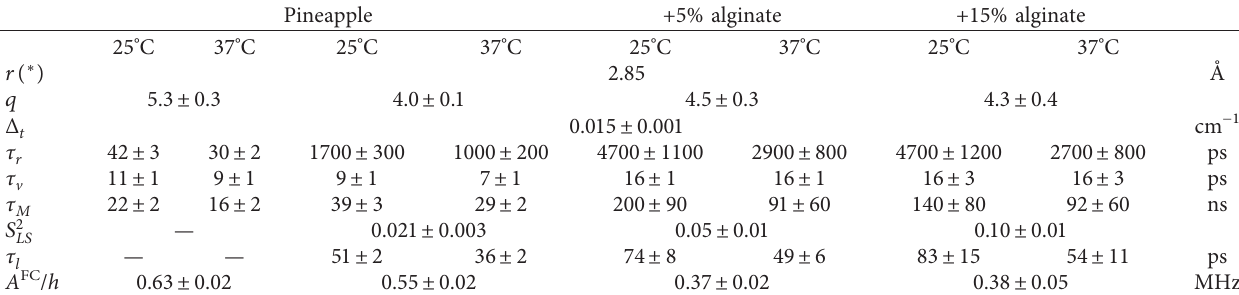
Table 1: Best fit parameters for pineapple juice without and with addition of alginate 5% or 15% w/w.